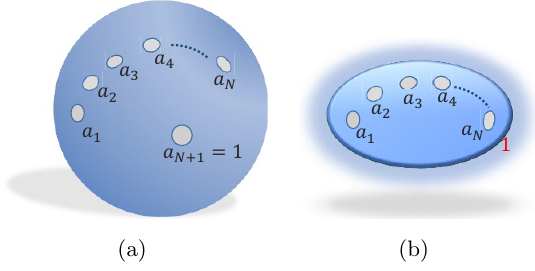
Figure 14 . (a) An (N+1)-puncture sphere. (b) A disk with N